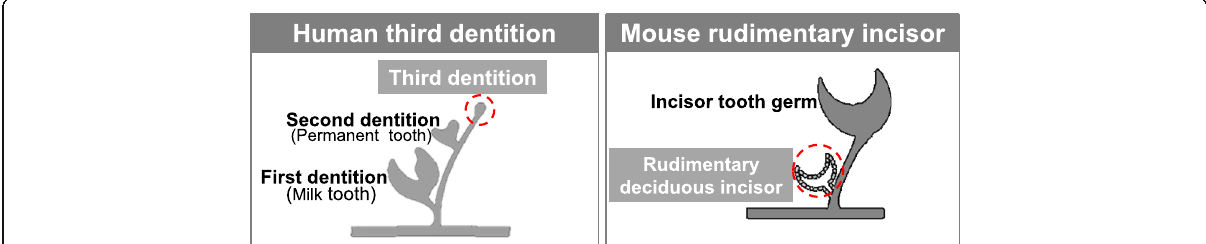
Fig. 2 Expanding the target from congenital tooth agenesis to general missing teeth (the third dentition). Both the human third dentition